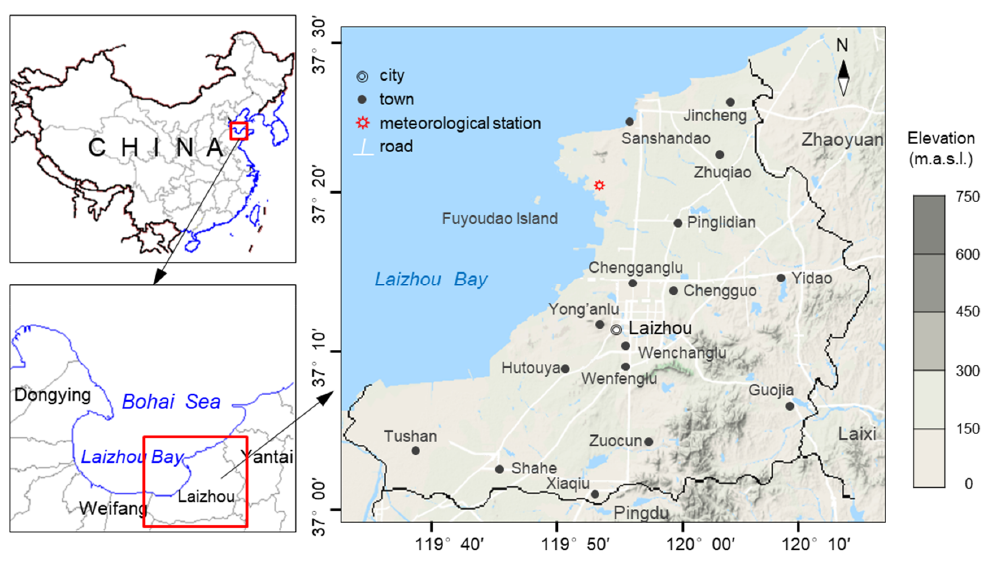
Figure 1. Location and elevation map of study area.